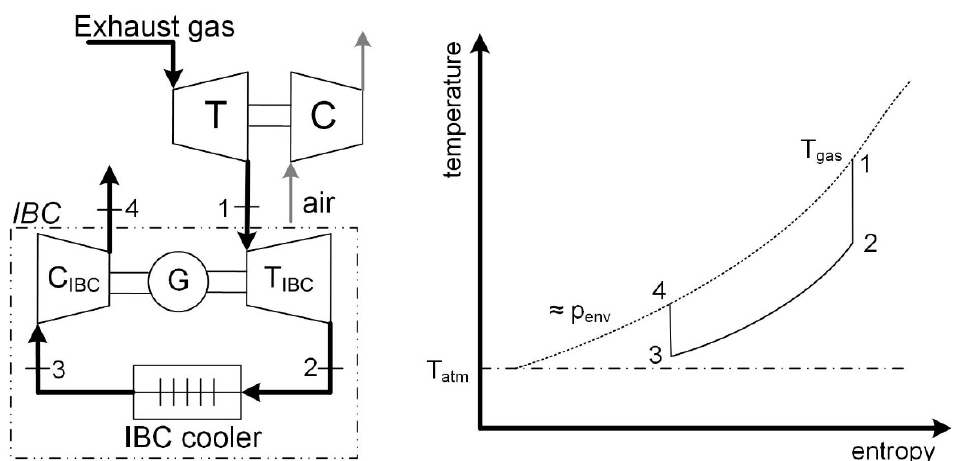
Figure 5. IBC layout and simple T-s diagram. Straight line is the IBC thermodynamic cycle, dotted one is the isobaric curve at environmental pressure, dashed-dot line is the isothermal line at atmospheriric temperature